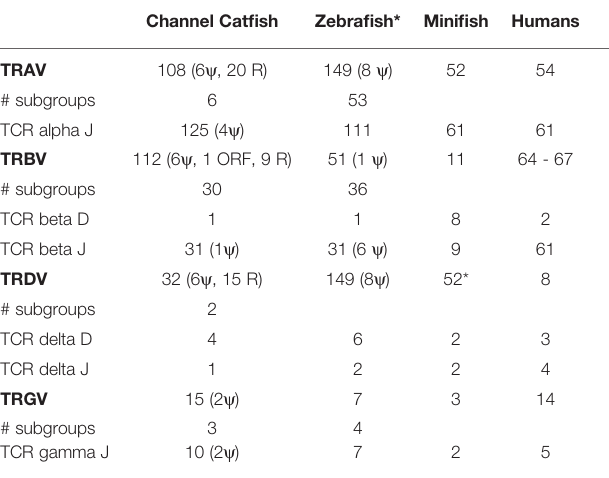
TABLE 1 | TCR variable (V), diversity (D) and joining (J) gene segment numbers in the channel cat fi sh, Ictalurus punctatus , zebra fi sh, Danio rerio , and mini fi sh, Paedocypris progenetica